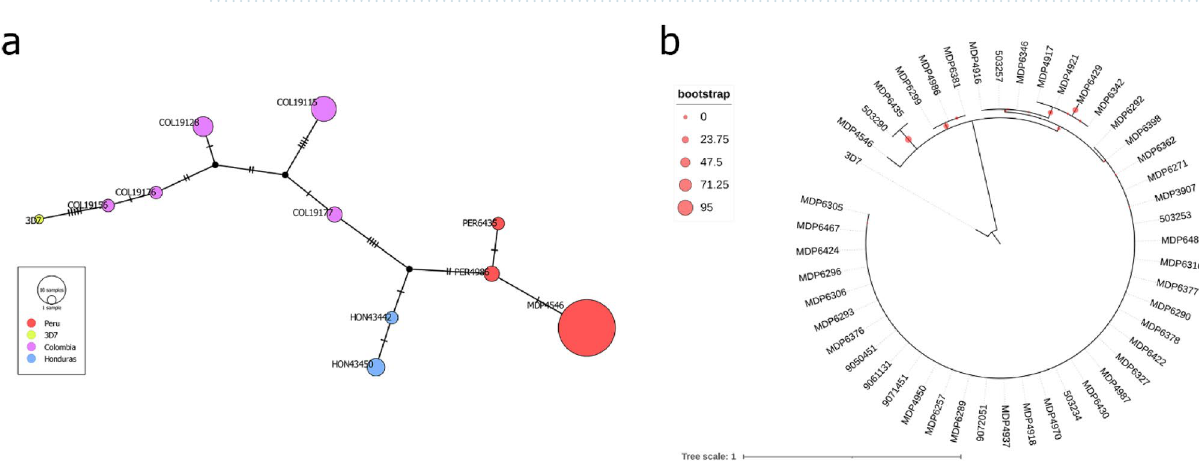
Figure 2. Discriminant analysis of principal components (DAPC) P. falciparum and P. vivax . The figure shows the population structure of 46 P. falciparum ( a ) and 145 P. vivax samples ( b ). The color scheme corresponds to each of the sites where samples were collected. DAPC shows the absence of clustering due to geographical origin.